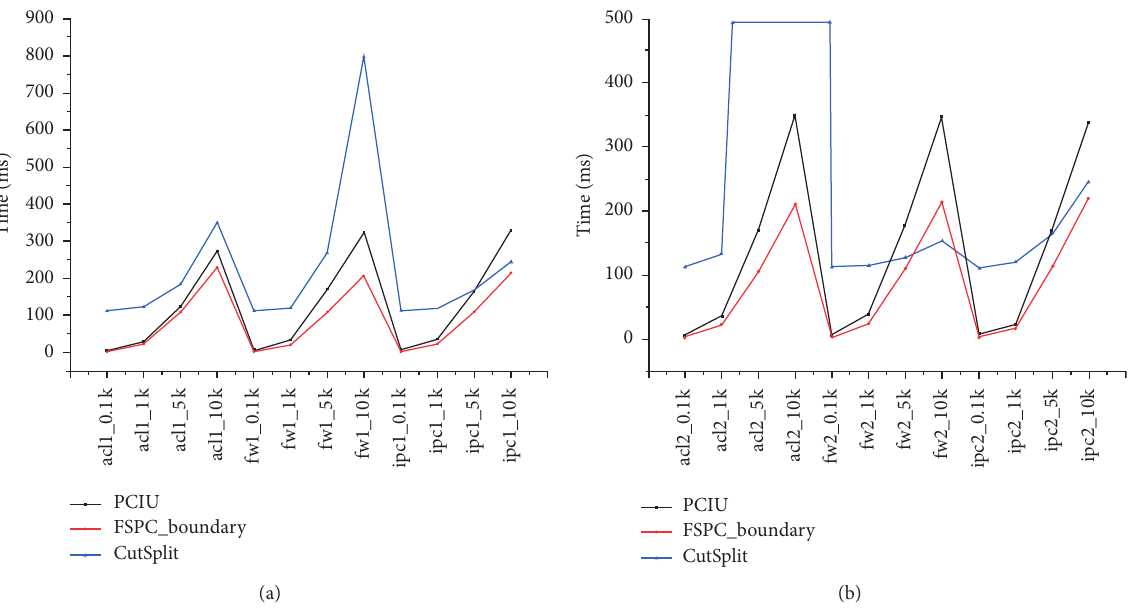
Figure 6: Comparisons of preprocessing time for different rule